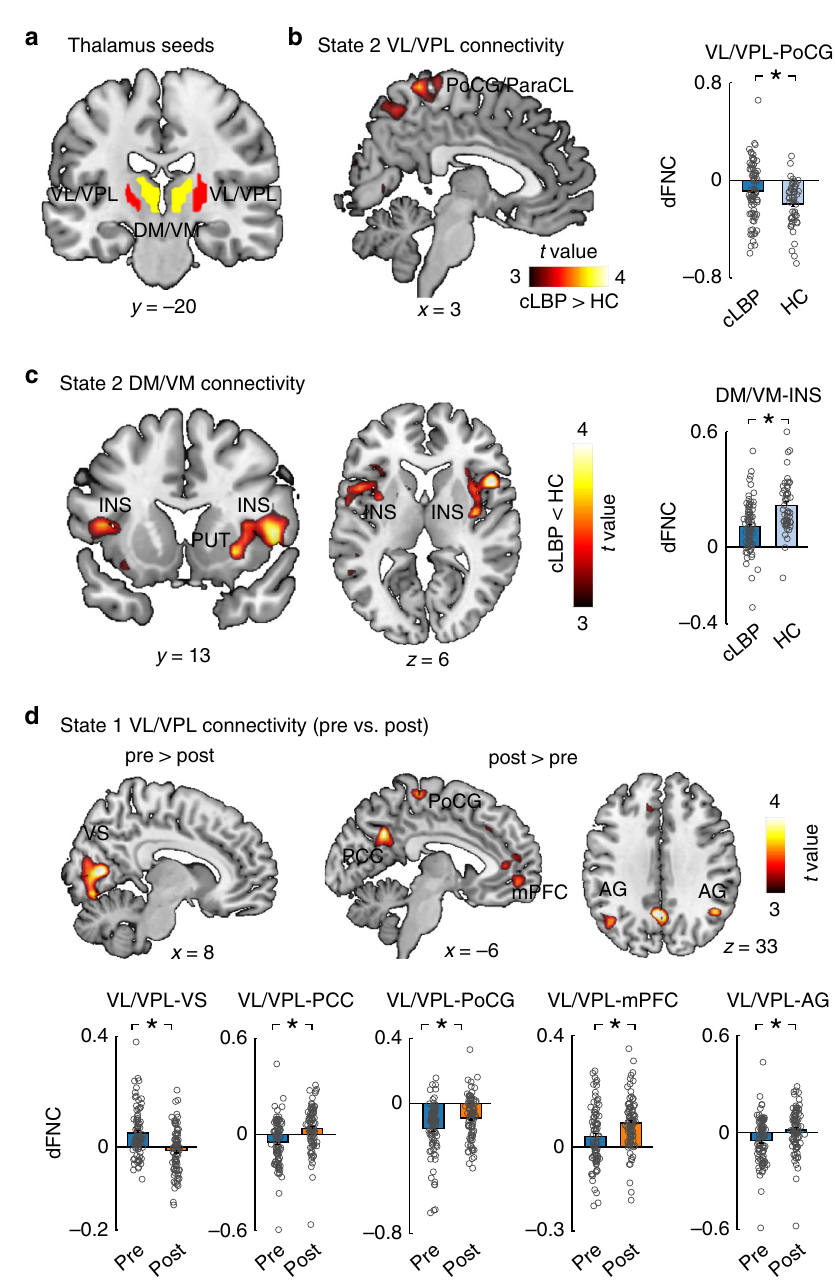
Fig. 5 Group differences of thalamus-whole-brain dFNC in two dynamic states. a Two seeds, including the ventral lateral/posterolateral (VL/VPL) nucleus and dorsal/ventral medial (DM/VM) nucleus were identi fi ed by GICA and used in seed-based correlation analysis. b In State 2, cLBP patients had higher dFNC between the VL/VPL and postcentral gyrus (PCoG)/paracentral lobule (ParaCL) and c lower dFNC between the DM/VM and insula (INS). d In State 1, patients had weaker dFNC between the VL/VPL and visual cortex but stronger dFNC between the VL/VPL and PoCG and typical regions (i.e., medial prefrontal cortex [mPFC], posterior cingulate cortex [PCC], and angular gyrus [AG]) of the DMN. Data are presented as mean values ± SEM ( N = 90 and 74 for cLBP patients and HCs, respectively). We performed two sample t -test for panels b and c , and paired sample t -test for panel d , and reported two-sided p values. Statistical maps were thresholded at p < 0.005 at voxel level and p FDR < 0.05 at the cluster level. Comparisons of bars in panel D were corrected for multiple comparisons using FDR. Asterisks represent signi fi cant differences at two-sided p FDR < 0.05. Source data are provided as a Source Data fi Figure 5b, c show abnormal VL/VPL and DM/VM-based thalamocortical networks may underlie chronic pain pathophy- whole-brain dFNC of cLBP patients in State 2. Compared with siology in State 2. HCs, patients had signi fi cantly higher connectivity between the Direct comparisons of VL/VPL and DM/VM-based whole- VL/VPL and PoCG/ParaCL and lower connectivity between the brain dFNC between pre- and post-maneuver conditions showed DM/VM and bilateral insula (the statistical maps were set at a that cLBP patients had signi fi cantly decreased connectivity threshold of p < 0.005 at voxel level and p FDR < 0.05 at the cluster between the VL/VPL and visual cortex (i.e., the cuneus, calcarine, level). These results support our hypothesis that abnormal and lingual gyrus) but had increased connectivity between the